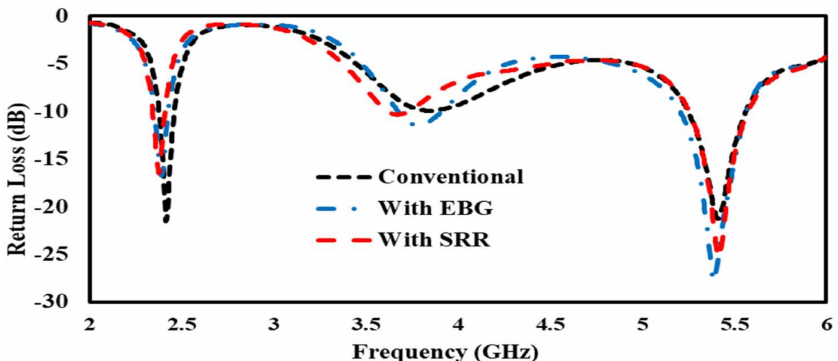
Figure 12. Reflection coefficient (S11) comparison of the conventional antenna with EBG- and SRR– based antennas.